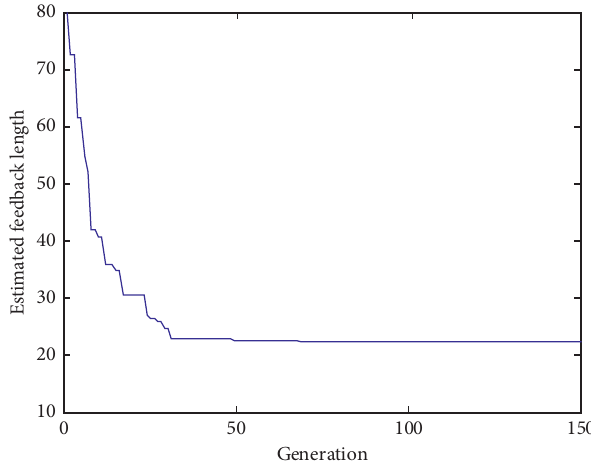
Figure 10: Convergence curve in the GA-based optimization.